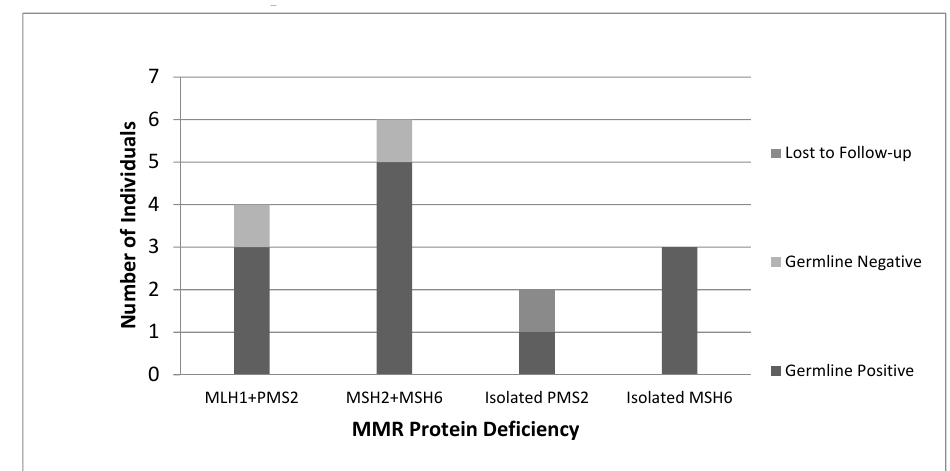
Figure 3. (Right): Results of genetic testing for all screen-positive individuals. Note: MLH1 + PMS2 categories refer to patients with absent MLH1 + PMS2 expression on IHC and absent MLH1 promoter methylation.